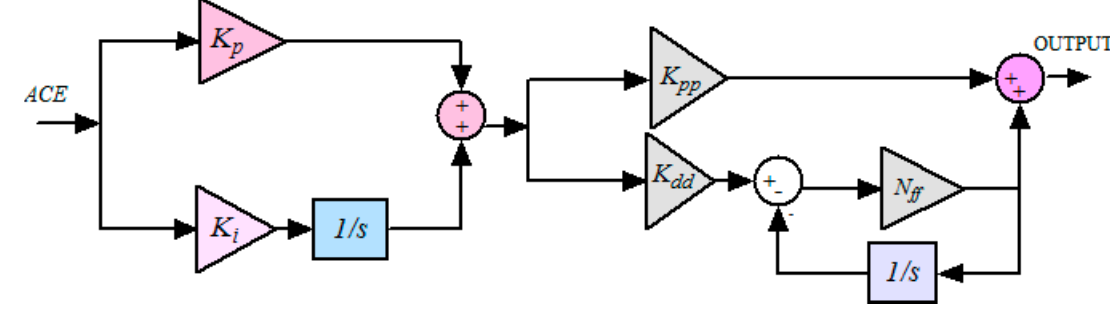
Figure 4. Dual-stage PI-PDF controller structures.